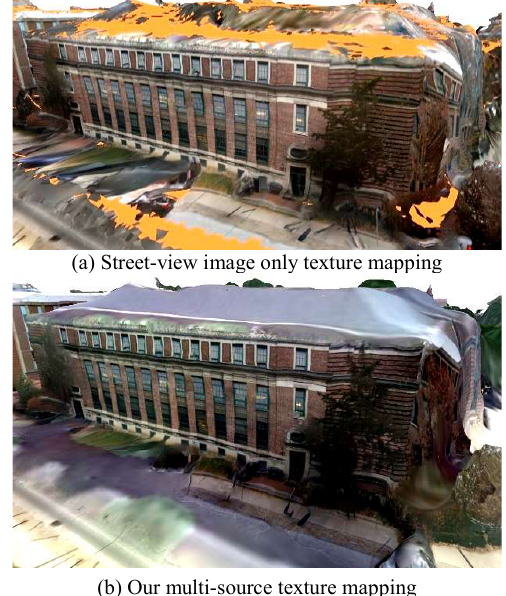
(b) Our multi-source texture mapping Figure 10. Textured models using only the street-view images (a), and textured models using both satellite and street-view images in our texture mapping method